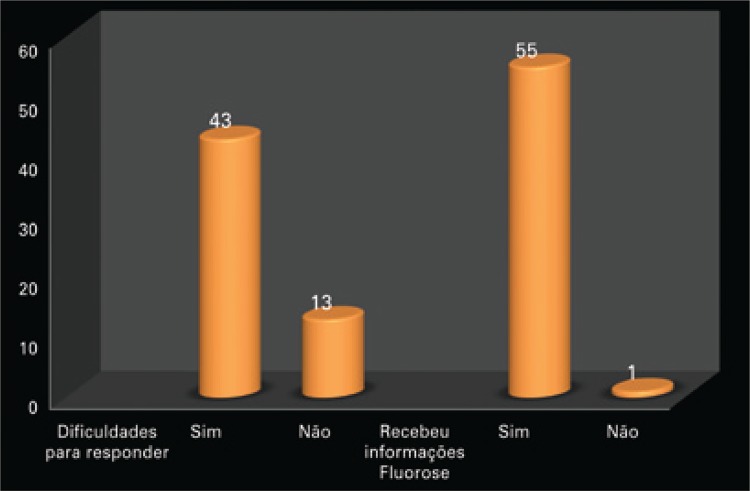
Dificuldade em responder ao questionário e informações sobre fluorose dentária